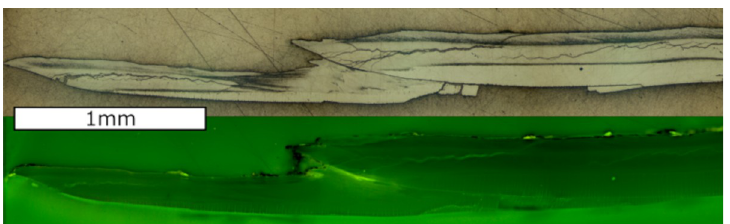
Fig 4. Microscopic shell images and elemental ratios of A . excavata . A) Mg/Ca, Sr/Ca and Na/Ca ratios of the fibrous (black line) and microgranular (red line) shell section of sample 14R plotted against distance from the ventral margin. B) Red lines indicate assumed yearly growth lines as seen from microscope pictures of the shell. C) Enlarged section of B) with the jagged edge on the shell surface (red circle) and dark areas (red square) from where the growth line emerges. Yellow dashed lines mark the laser track in the fibrous and microgranular shell layer. Black arrows in D mark microgrowth lines. Scale bars are 1 mm long. Width of the picture in panel D is 1mm. Additional figures are given in the (S7 Appendix).